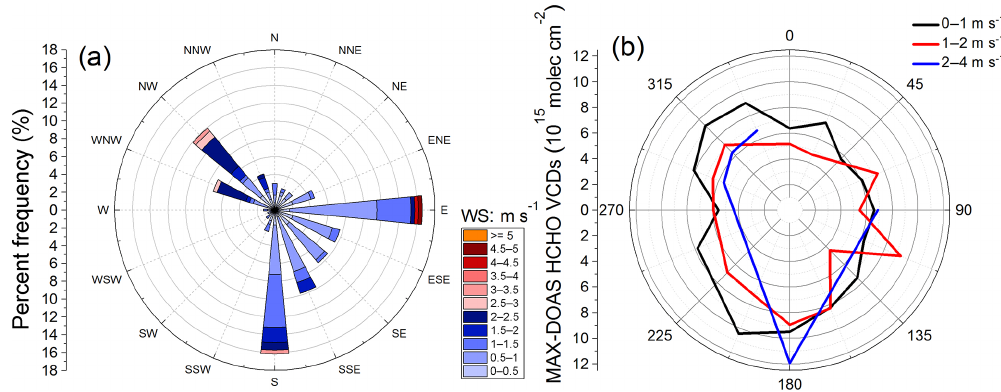
Figure 10. (a) Wind rose and (b) dependence of HCHO VCD (10 15 moleculescm − 2 ) on wind directions for different wind speeds.